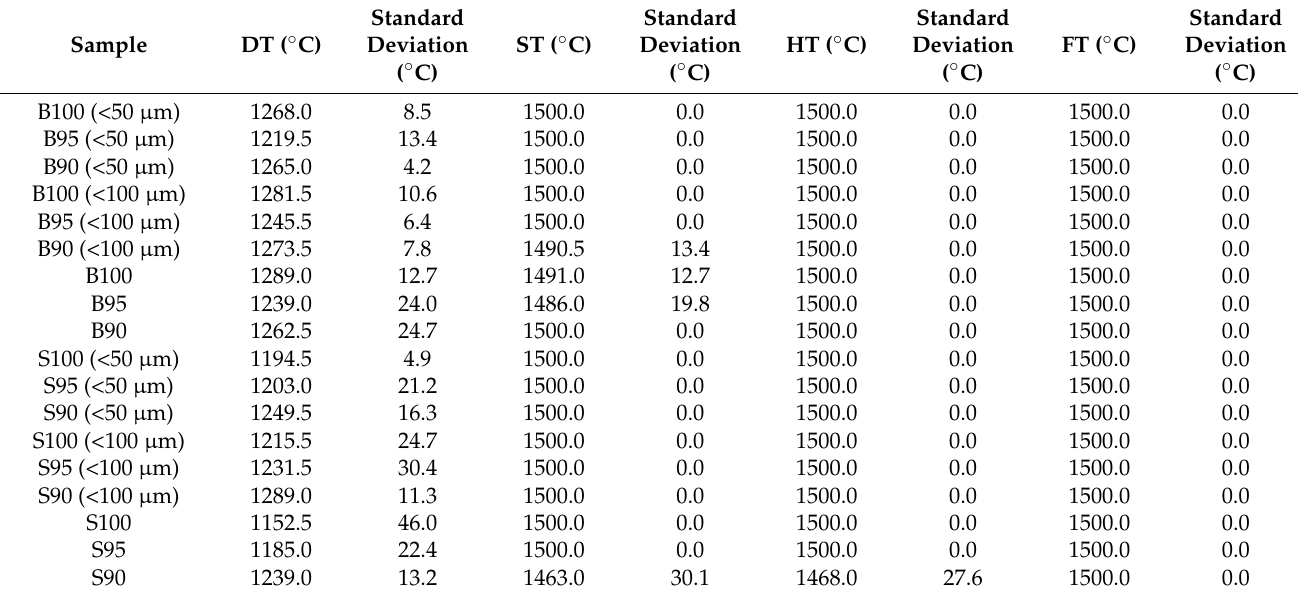
Table 3. Resulting values of ash melting temperatures prepared at 815 ◦ C with their standard